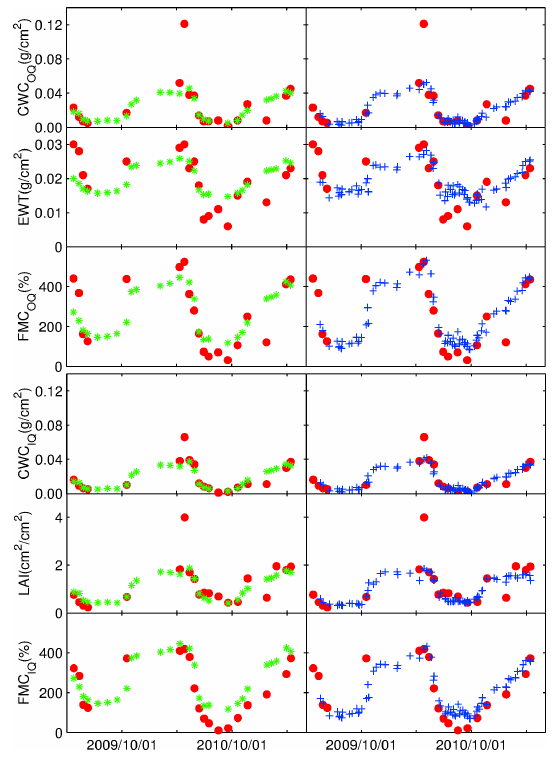
Figure 9. Temporal evolution of the observed (red circles) and esti- mated FMC OQ , FMC IQ , EWT, LAI, CWC OQ and CWC IQ obtained for proximal sensing (green asterisks) and MODIS (blue crosses). Fitting equations are presented in Table